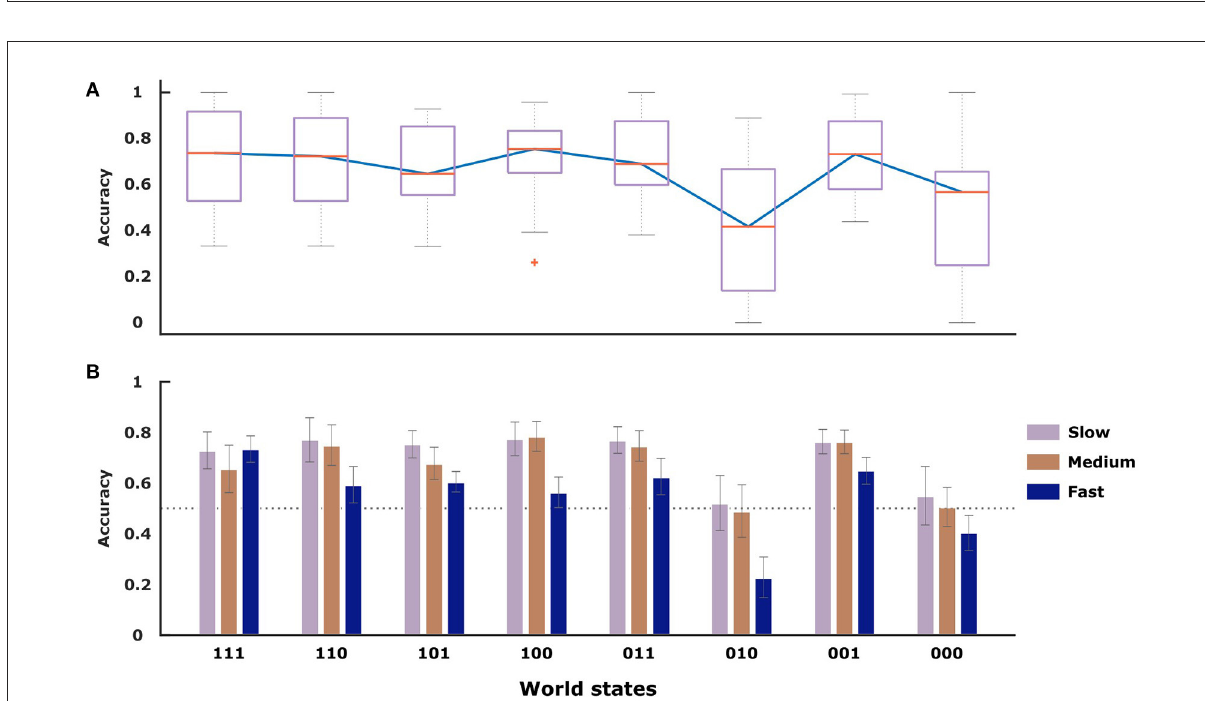
FIGURE5 The selection accuracy indicates how frequently subjects chose the class that was more probable. (A) Selection accuracy averaged across participants ( n = 16) for each stimulus type. (B) Selection accuracy averaged across participants ( n = 16) for each stimulus type and condition. The gray error bars show standard error of the